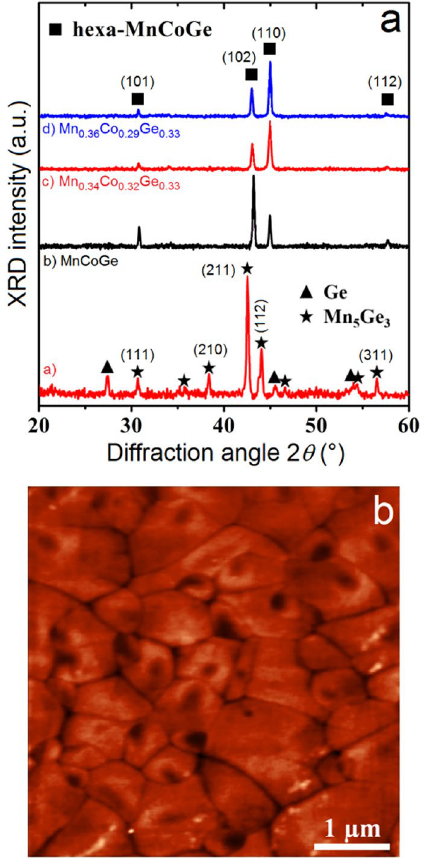
Figure 2. Microstructures of the 50 nm-thick Mn 5 Ge 3 film and of the 150 nm-thick Mn x Co y Ge 1− x − y films. ( a ) X-ray diffractograms measured on